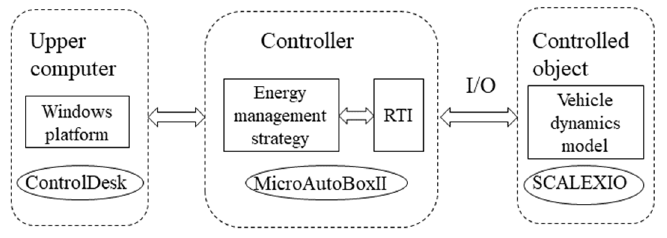
Figure 16. Structure diagram of the HIL test platform.